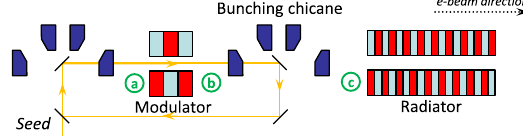
FIG. 3. Layout for the HGHG setup with an optical, resonator- like seed recirculation feedback system. The underlying principle is the same as with HGHG shown in Fig. 1. However, a seed laser pulse is only needed once per macropulse and the optical, resonator-like seed recirculation feedback system is used to maintain the seed power for successive electron bunches in the burst.